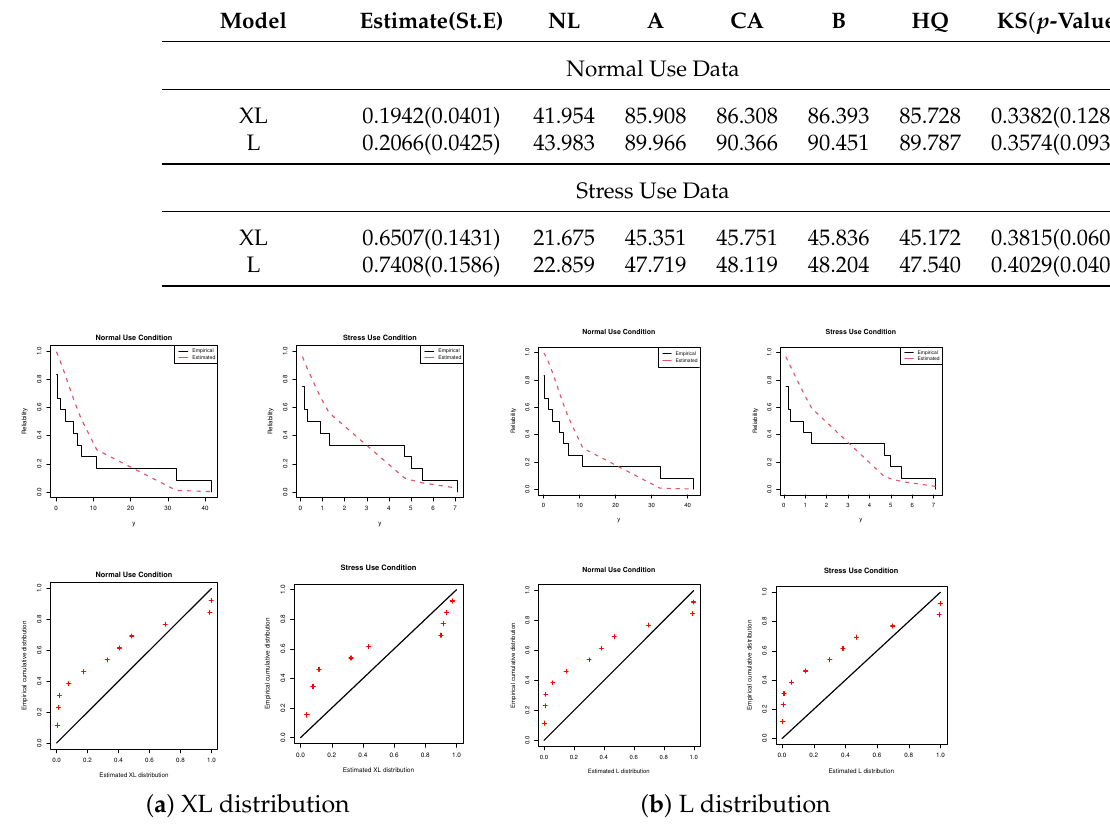
Figure 6. Fitted reliability ( top ) and PP ( bottom ) plots from insulating fluid